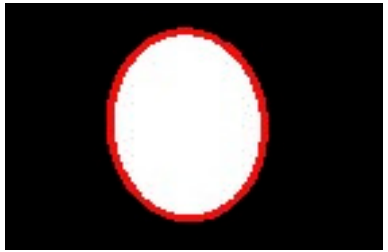
Figure 8. Elliptical matching (in red) of the sensor boss surface (in white).